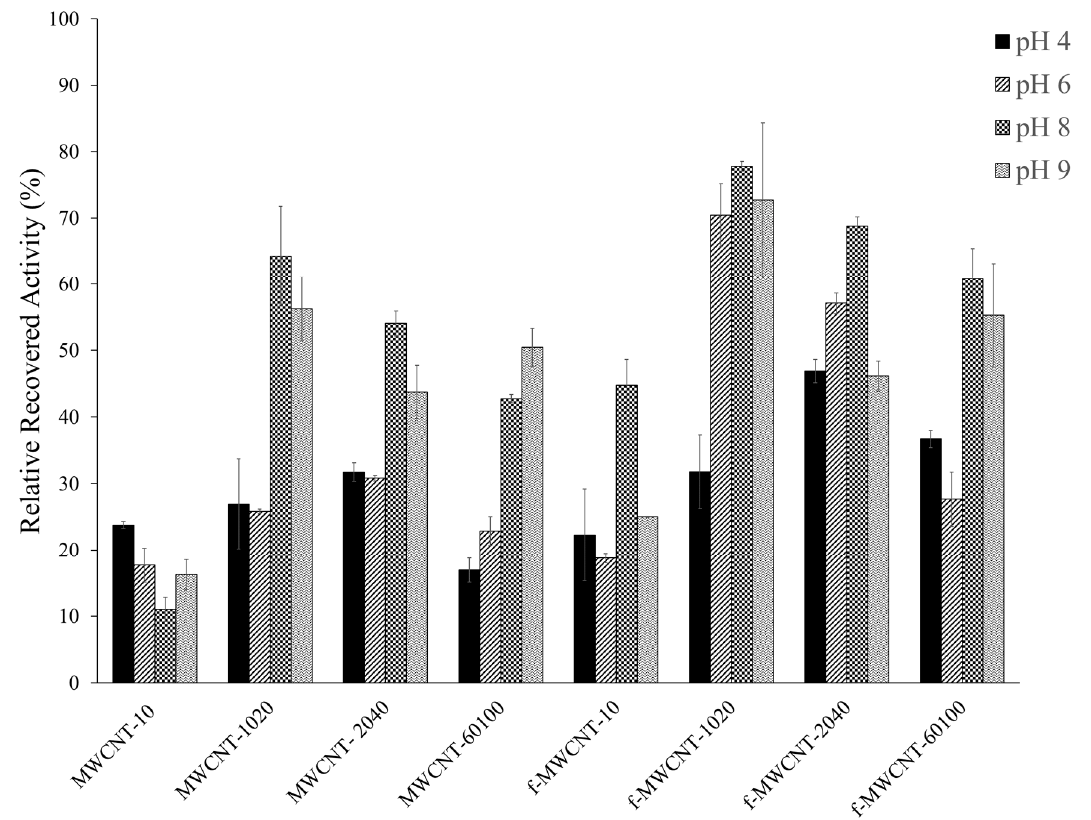
Figure 2. Effect of pH and diameter of multi-walled carbon nanotubes (MWCNTs) on the relative recovered activity ( RRA ). Immobilization of 0.086 mg/mL of L-asparaginase (ASNase) onto 2 mg of pristine multi-walled carbon nanotubes (MWCNTs) and functionalized MWCNTs (f-MWCNTs) for 60 min of contact time. Error bars correspond to the standard deviation between replicates.